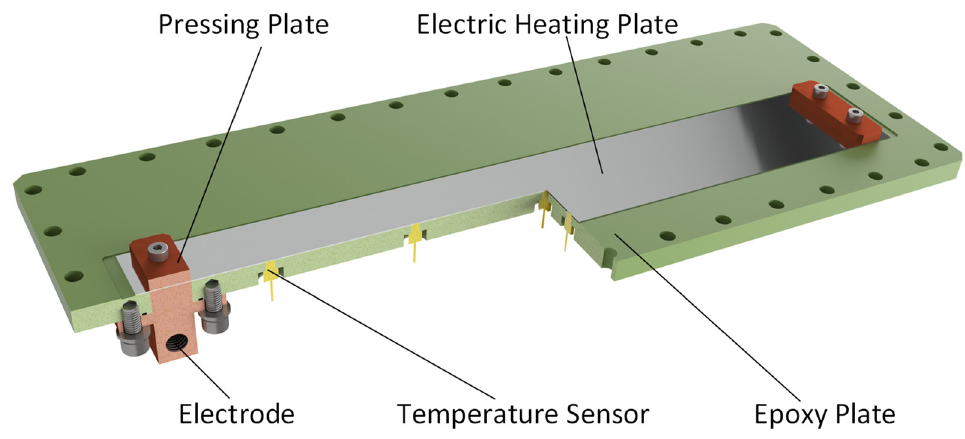
Figure 4. The structure of one Figure 4. T he structure of one cover.